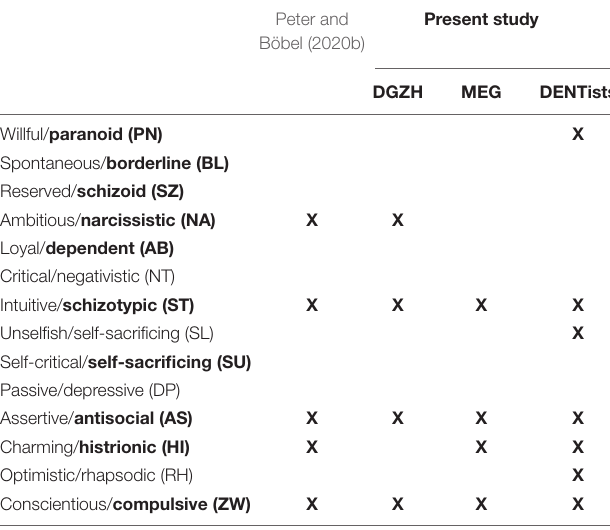
TABLE 5 | In the personality styles labeled X , there is no difference between the securely and insecurely attached participants of the original study of Peter and Böbel (2020b) ( Figure 1 ) and of the three samples of the present